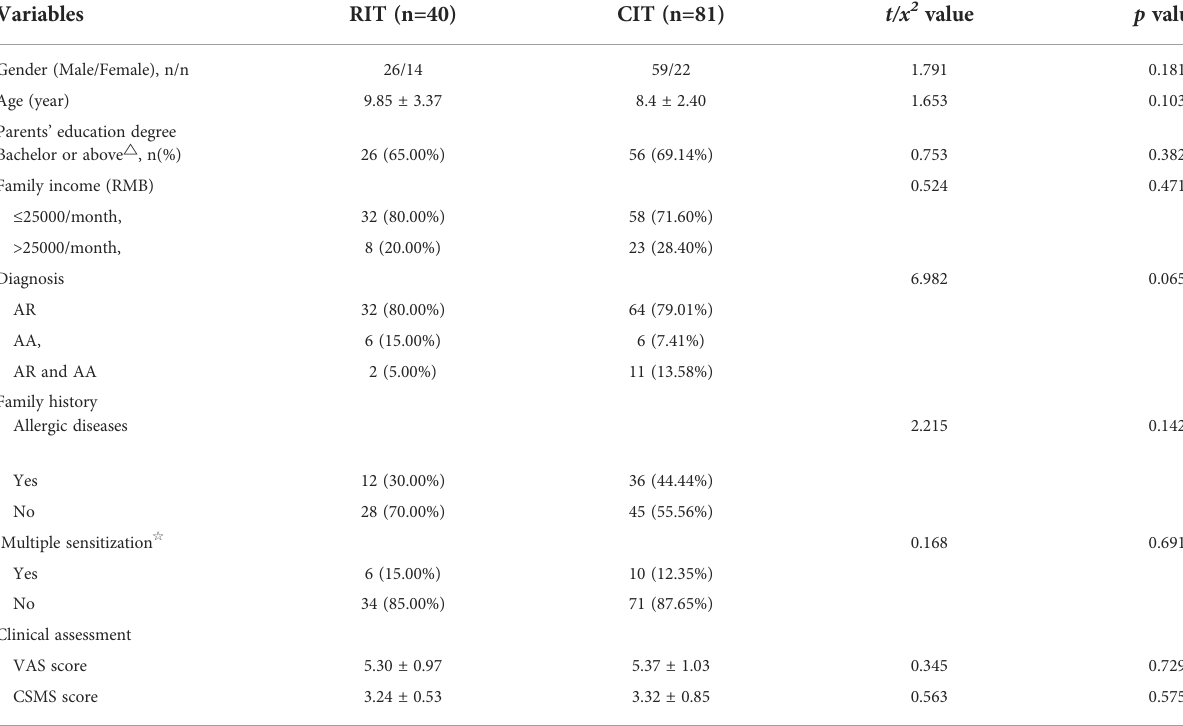
TABLE 2 Patient demographics and baseline